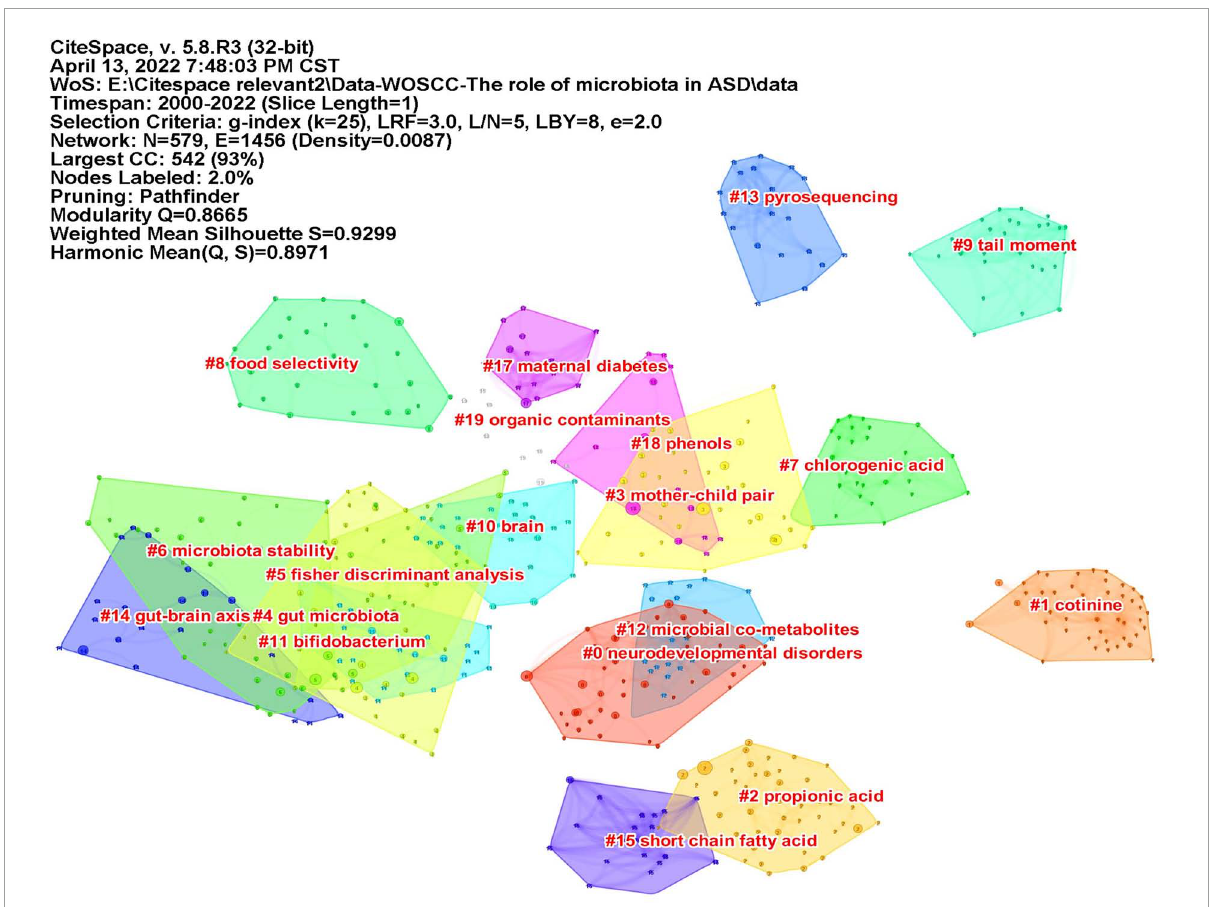
FIGURE11 The map of co-cited reference clusters. The clusters are arranged in the descending order of their